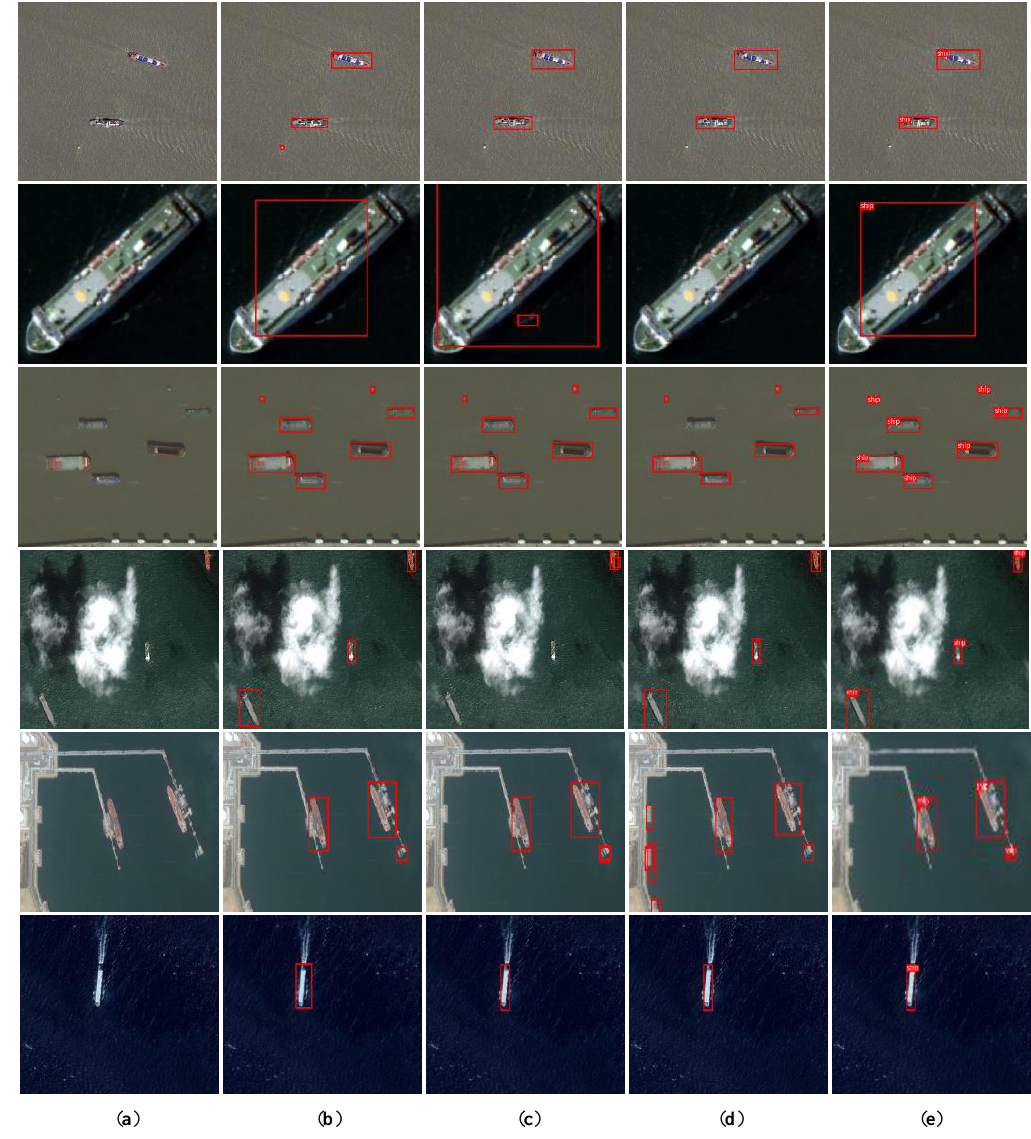
Figure 15. Detection results of satellite remote sensing images from different models. ( a ) Original Images; ( b ) Faster Regions Convolution Neural Network (Faster R-CNN); ( c ) Single Shoot MultiBox Detector (SSD); ( d ) You Only Look Once v3: An Incremental Improvement (YOLOv3); ( e ) Convolutional Feature Fusion Ship Detection Network (CFF-SDN).